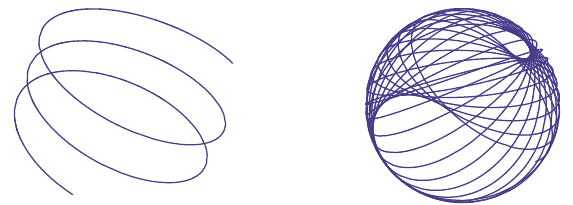
Figure 1: The evolution of the vector-parameter (65) and the trace of the corresponding rotation acting on the vector (3,14, 25)